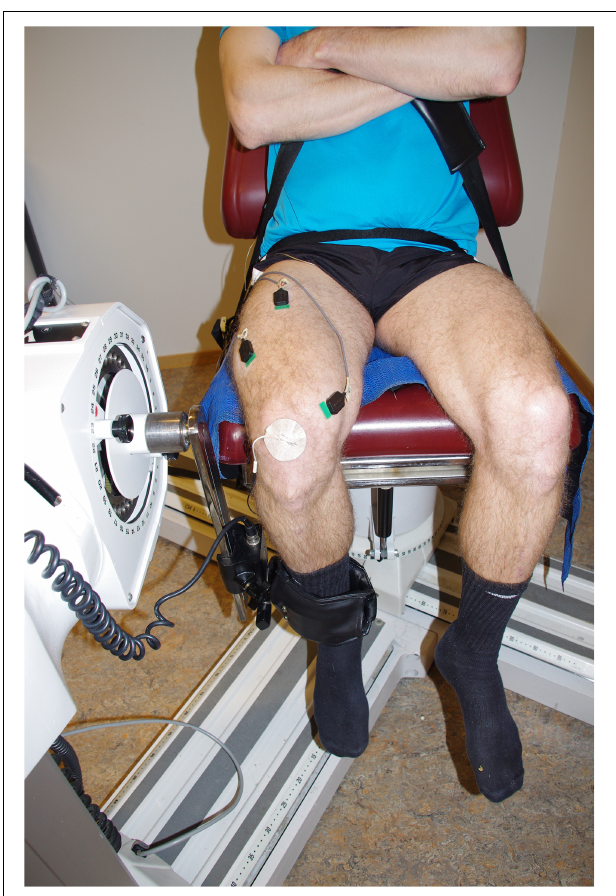
FIGURE 2 | Photo of a subject secured to the dynamometer. Electromyography (EMG) of surface sensors and the reference sensor applied to the patella is